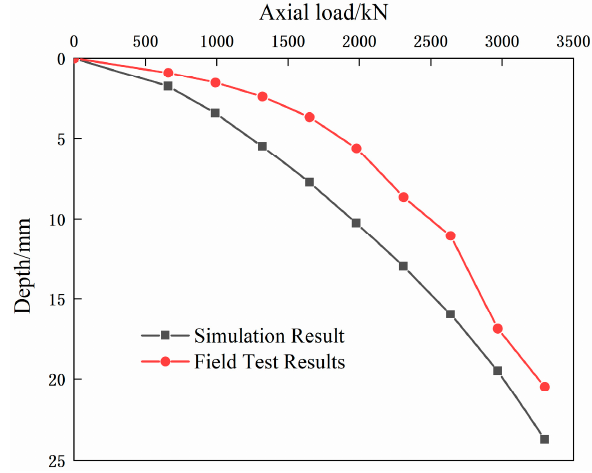
Figure 5. q–s curves of the simulation and the field test results.